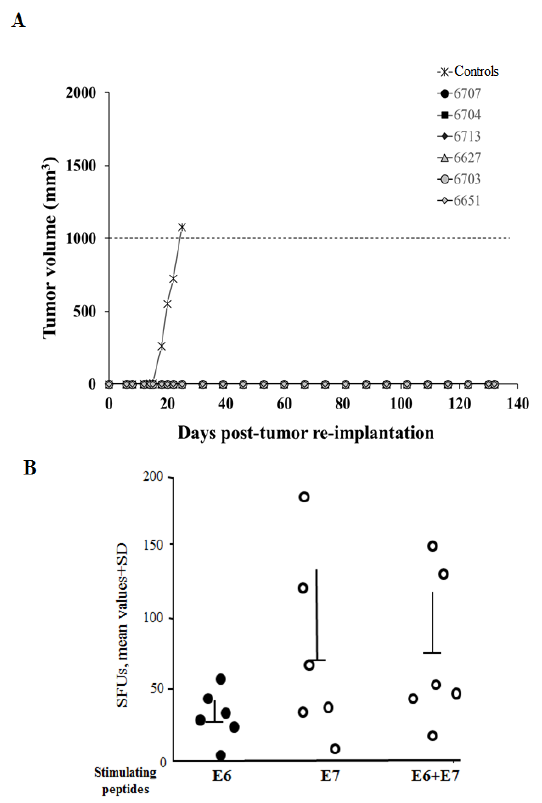
Figure 6. Antitumor therapeutic effect against re-implanted TC-1 cells. ( A ) Tumor growth curves. Cured C57 Bl/6 mice were re-challenged with 2 × 10 5 TC-1 cells, and the growth of tumor masses were followed over time. As control, age-matched naïve mice were inoculated with the same number of cells, and the mean of tumor volumes are reported. Tumor sizes were measured every 2–3 days. The identification number of each injected mouse is shown. ( B ) CD8 + T cell immunity in mice challenged, immunized, and re-challenged with TC-1 cells. Nineteen weeks after cell re-implantation, mice were sacrificed, and splenocytes tested for E6- and/or E7-specific CD8 + T cell immunity by IFN- γ EliSpot assay. The number of IFN- γ SFUs/well are shown as mean values of triplicates after subtraction of values from wells treated with unrelated peptides. Intragroup mean values + SD are